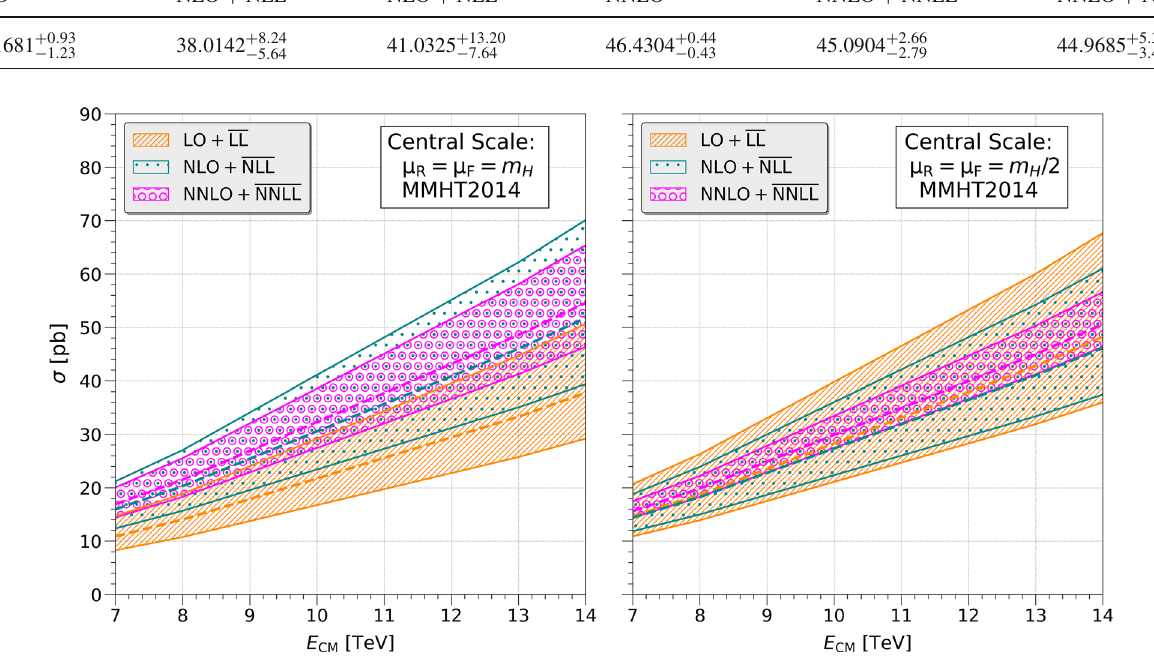
Fig. 5 SV + NSVresummedcrosssectionsplottedagainstthehadronic centre-of-mass energy(E CM ) till NNLO + NNLL accuracy. The band corresponds to the scale variation around the central scale choices